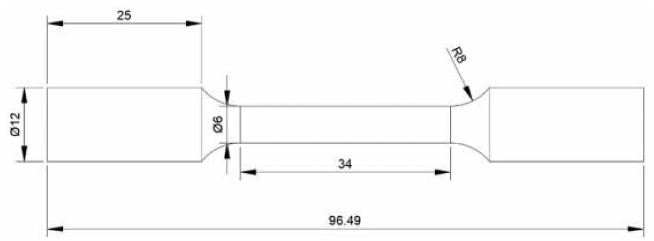
Figure 3. The size of the axial tensile specimen (units: mm).